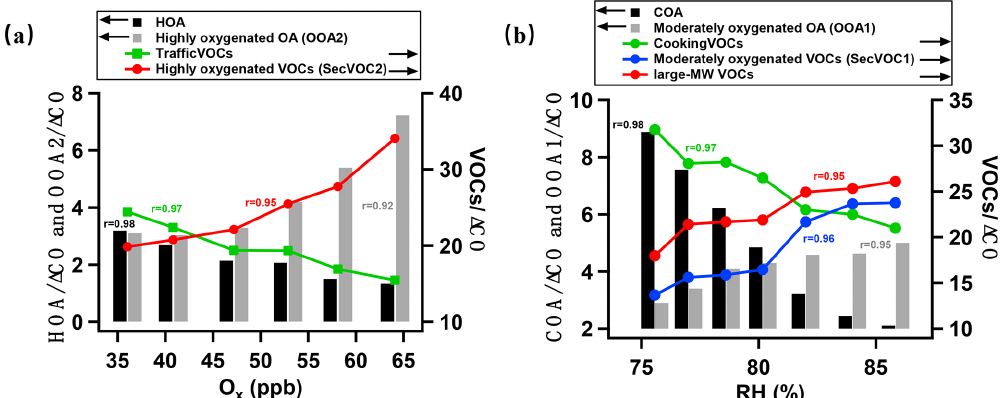
Figure 5. Daytime and nighttime evolution of key species against O x and RH, respectively. (a) Daytime oxidation showing the primary emissions of traffic source in gas and aerosol phases, including HOA, traffic VOCs, and secondary products, including SecVOC2 and OOA2, with concentrations all normalized by (cid:49) CO. (b) Nighttime oxidation showing the primary emissions of cooking source in gas and aerosol phases, including COA and cooking VOCs and secondary products, including SecVOC1, large-MW VOC, and OOA1, with concentrations all normalized by (cid:49)